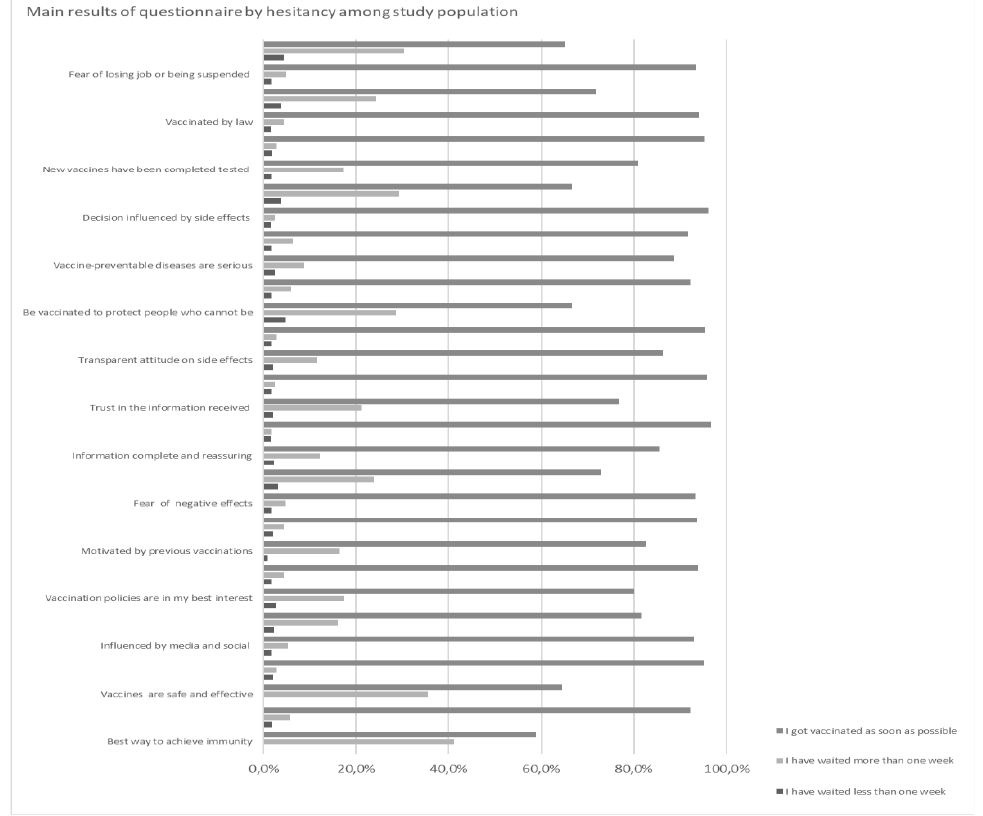
Figure 1. Questionnaire answers by hesitancy levels.